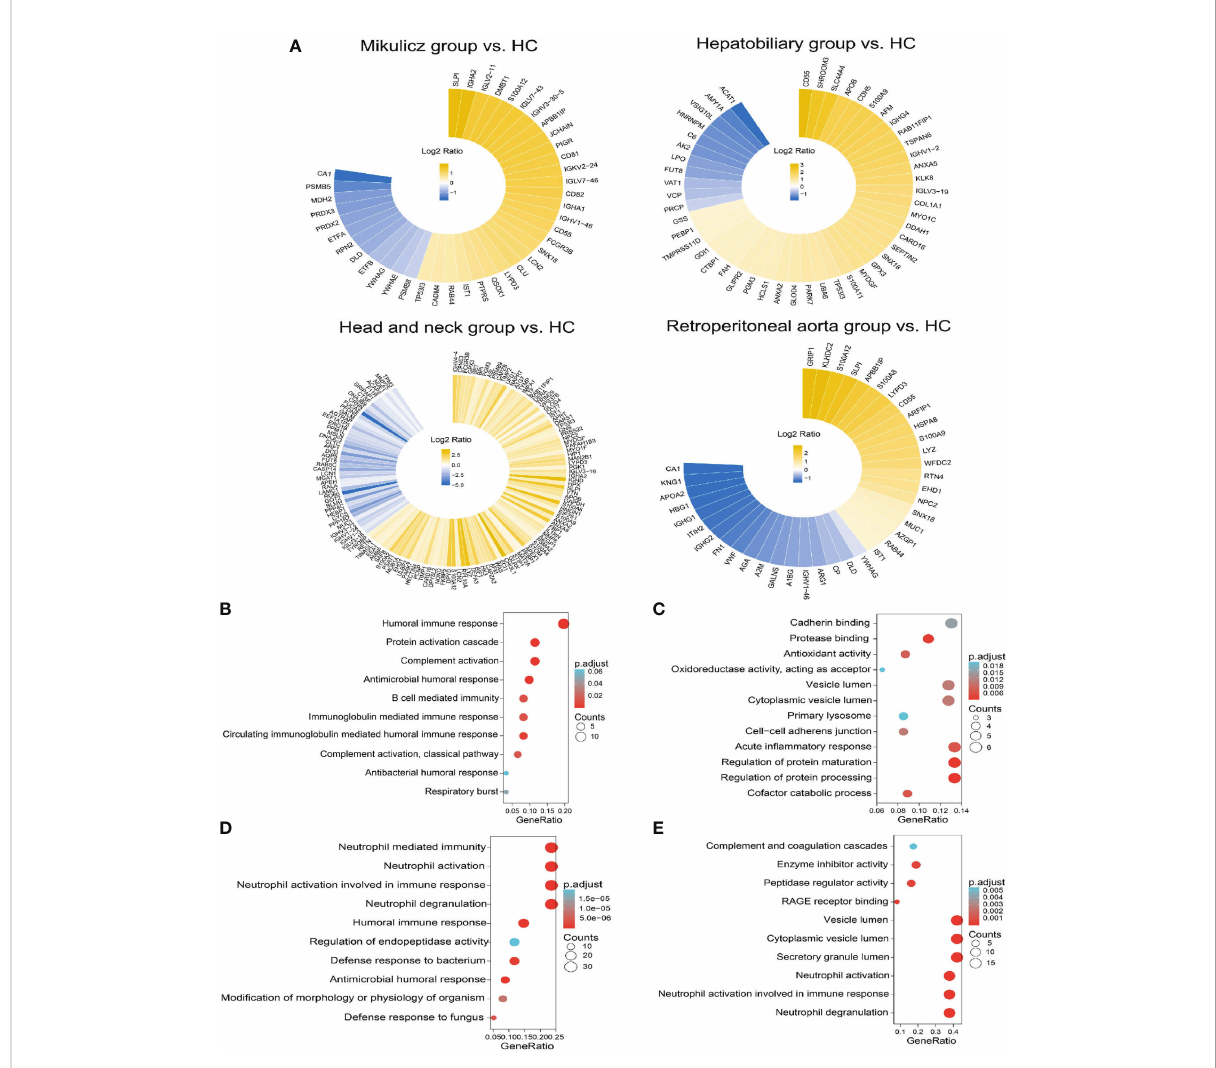
FIGURE 4 Summary of DEPs and enriched GO categories in the comparison between IgG4-RD with four subgroups and HC. (A) Circular heat map of up and down expressed of DEPs in comparisons of Mikulicz group vs. HC, Hepatobiliary group vs. HC, Head and neck group vs. HC and (D) Retroperitoneal aorta group vs. HC in saliva. Yellow and blue block represents the unexpressed and down expressed DEPs in each IgG4 phenotype, respectively. (B) Enriched GO category of DEPs in the comparison between Mikulicz group and HC. (C) Enriched GO category of DEPs in the comparison between Hepatobiliary group and HC. (D) Enriched GO category of DEPs in the comparison between Head and neck group and HC. (E) Enriched GO category of DEPs in the comparison between Retroperitoneal aorta group and